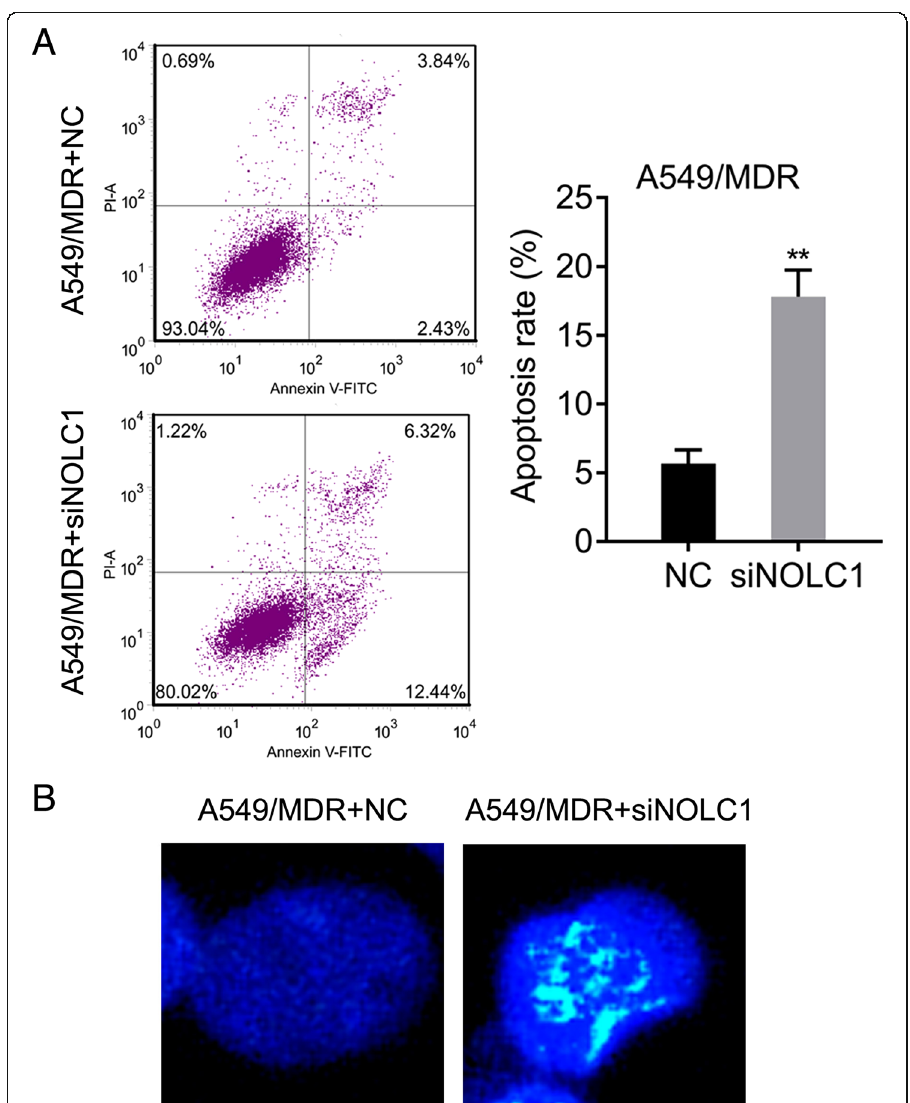
Fig. 5 NOLC1 knockdown significantly promoted cell apoptosis in A549/MDR cells. a Flow cytometry analysis of A549/MDR cells stained with Annexin V and PI. The effect of siRNA-mediated NOLC1 knockdown on apoptosis was analyzed. Data were expressed as means ± SD of at least three experiments. b Hoechst staining assay was used to analyze the percentage of cells with fragmented nuclei in A549/MDR cells. ** p <0.01 versus